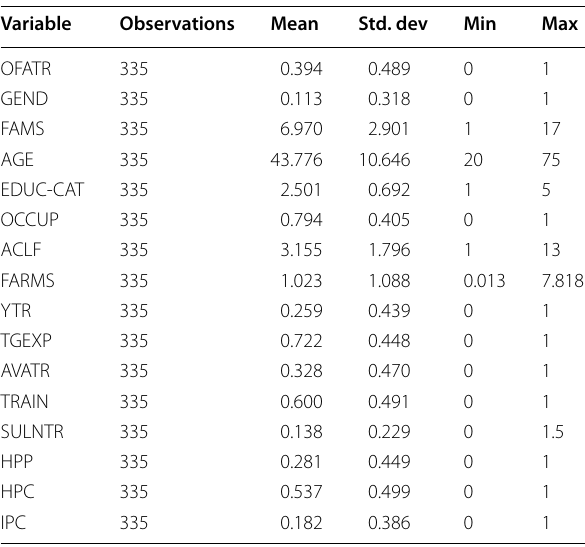
Table 3 Summary